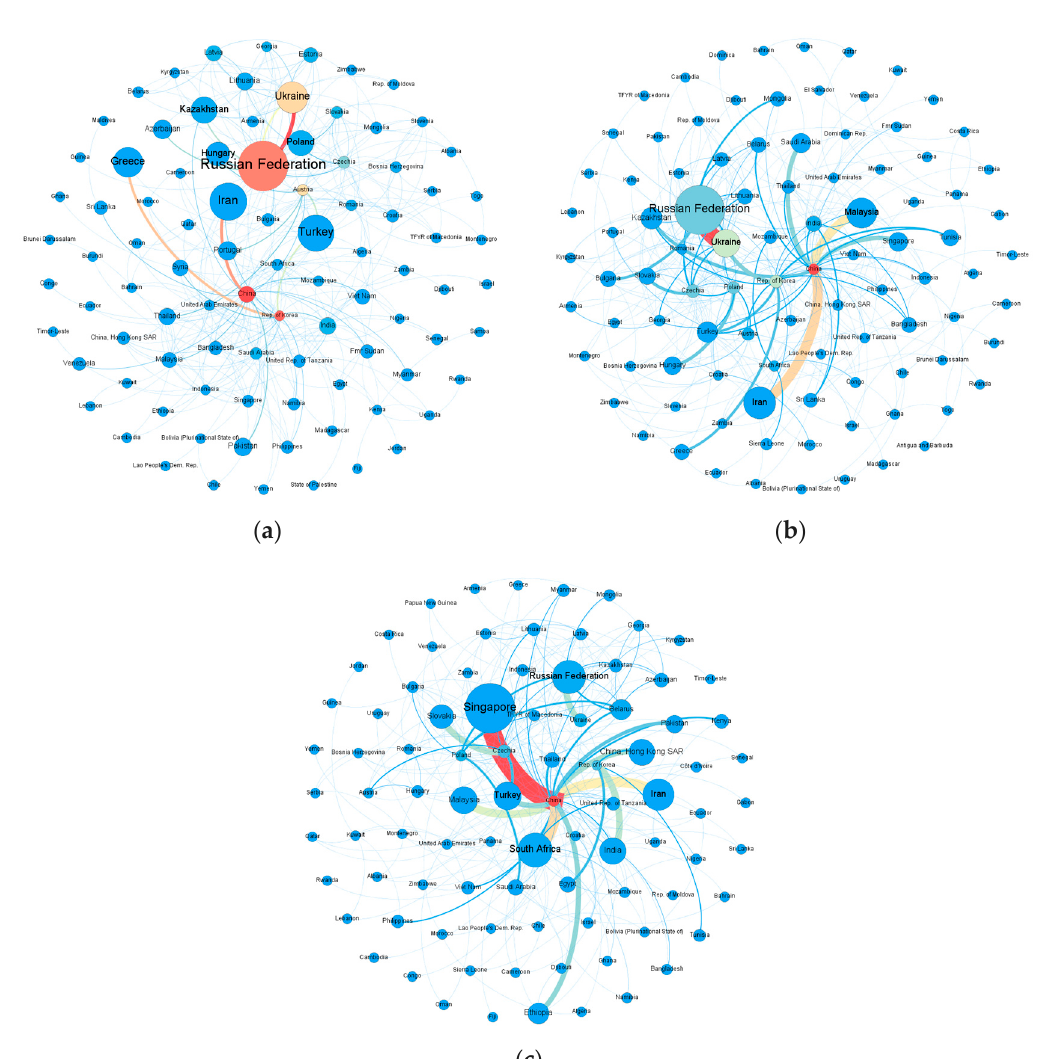
Figure 7. Trade networks of rail locomotives and self-propelled coaches and vans products in the BRI region: ( a ) phase 1 (2003–2008), ( b ) phase 2 (2009–2013), and ( c ) phase 3 (2014–2017). The size of the node indicates the in-strength centrality, and the color is given by the out-strength centrality. The diameter and color of edges represent the volume of the trade flow. Red represents a high value and blue represents a low value.